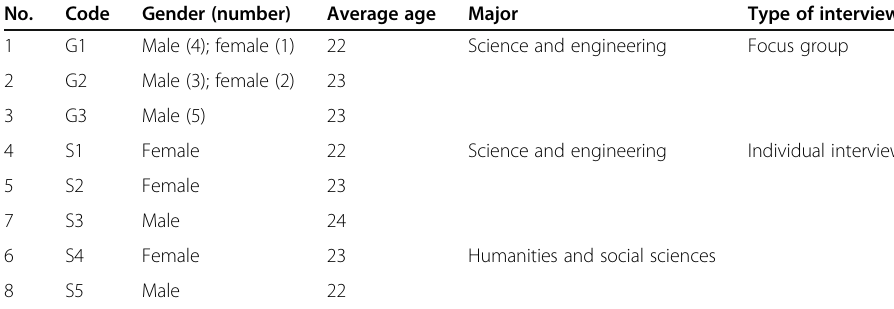
Table 1 Profile of the interview